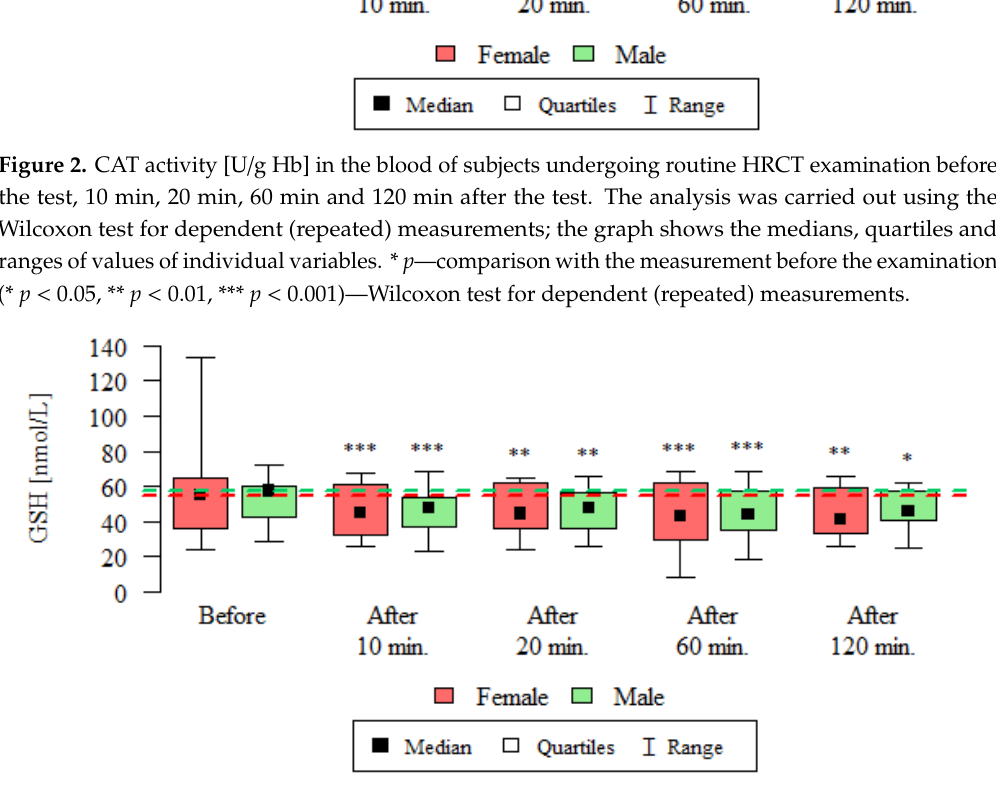
Figure 3. GSH concentration [nmol/L] in the plasma of subjects undergoing routine HRCT examination before the test, 10 min, 20 min, 60 min and 120 min after the test. The analysis was carried out using the Wilcoxon test for dependent (repeated) measurements; the graph shows the medians, quartiles and ranges of values of individual variables. * p —comparison with the measurement before the examination (* p < 0.05, ** p < 0.01, *** p < 0.001)—Wilcoxon test for dependent (repeated) measurements.